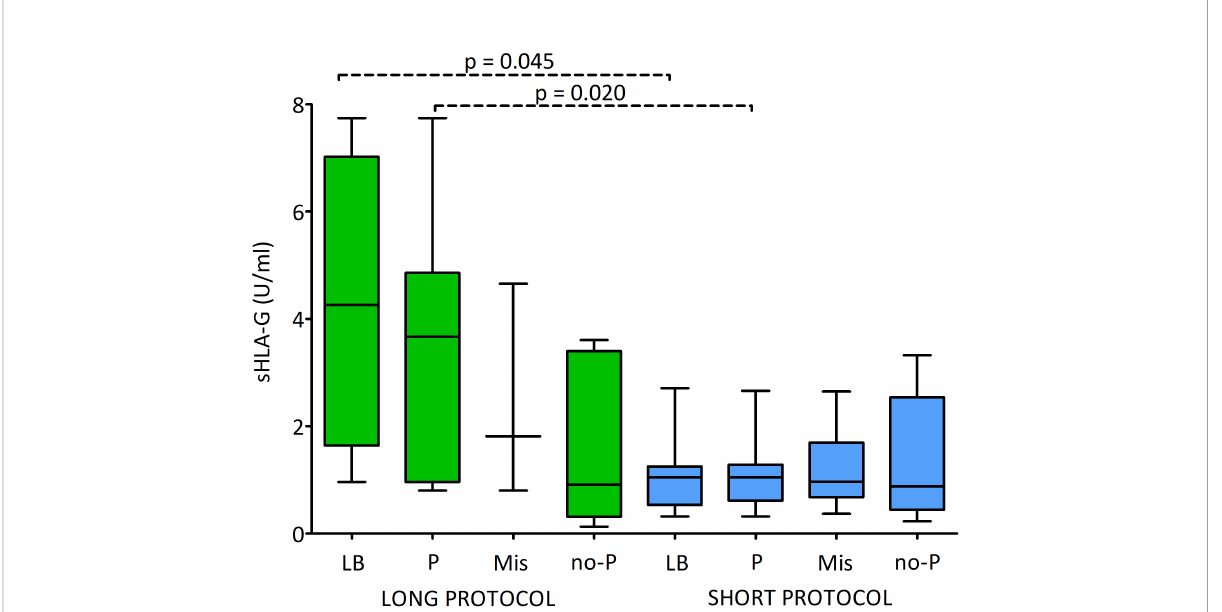
FIGURE 7 In fl uence of soluble HLA-G (U/ml) secreted by embryos and long/short cycle on the pregnancy outcome. Green boxes represent the level of sHLA-G measured in embryo media in the long cycle, blue boxes – in the short cycle. Boxes are drawn from the fi rst quartile (25 th percentile) to the third quartile (75 th percentile). Black lines in boxes are medians. Whiskers represent 10-90 percentiles. P-values are calculated by Mann- Whitney test. Dashed line – p-value resulting from analyses with insuf fi cient number of embryos. P-values are calculated by Mann-Whitney test. LB means live birth, P – pregnancy, MIS – miscarriage, no-P – no